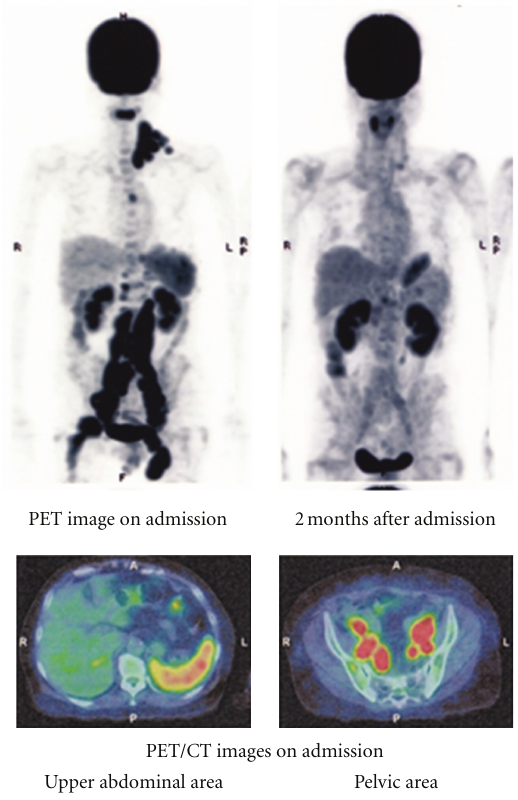
Figure 1: Imaging test results: the coronal PET image (upper left) shows wide spread pathological uptake of radiotracer (FDG) in cervical, supraclavicular, mediastinal, para-aortic, peri-iliac and inguinal lymph nodes and spleen. A second PET/CT scan performed 2 months after admission (upper right) shows complete resolution of the abnormal FDG activity. Fused PET/CT image on admission (lower left) shows moderate FDG uptake in the spleen.